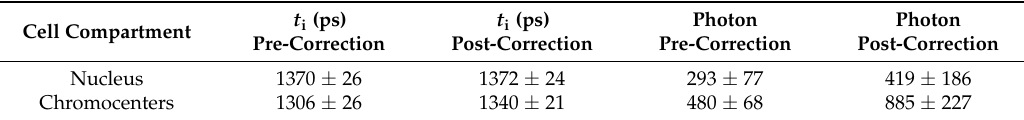
Table 2. Pile-up and counting loss corrections of FLIM